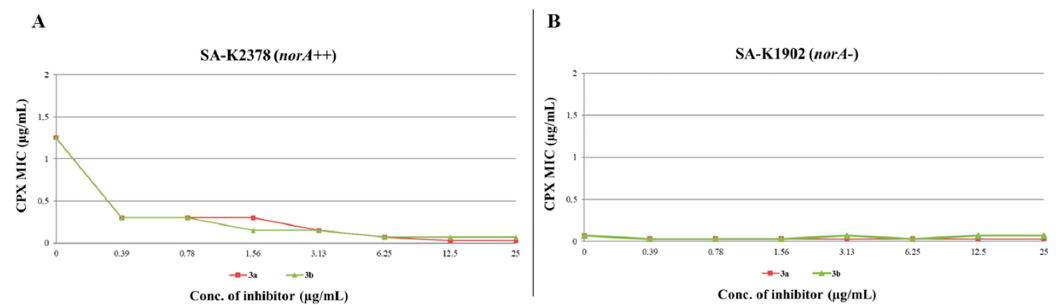
Figure 5. CPX MIC reduction in checkerboard assays of derivatives 3a and 3b in combination with CPX against ( A ) SA-K2378 ( norA ++ ) and ( B ) SA-K1902 ( norA- ). An antibiotic MIC reduction ≥ 4-fold indicated